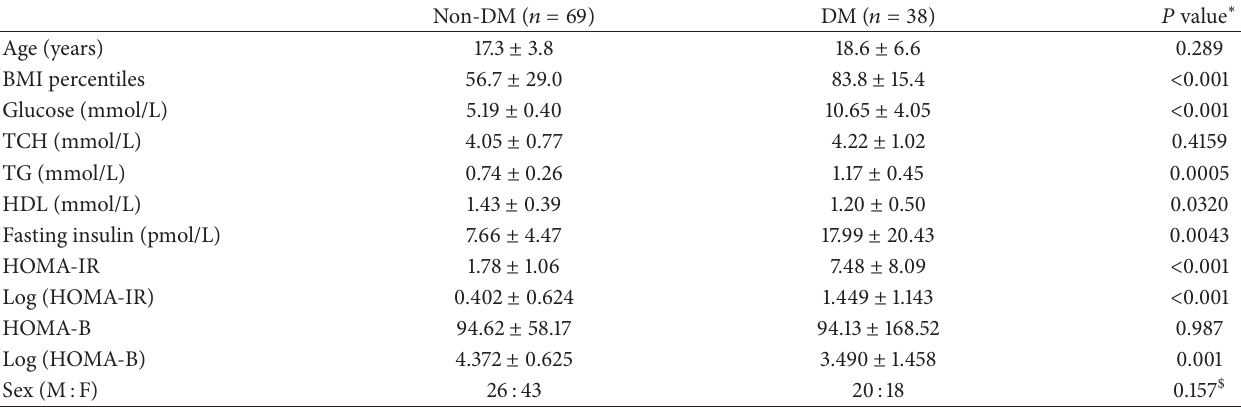
Table 1: Clinical and metabolic features between normal controls and type 2 diabetic subjects in the present study.